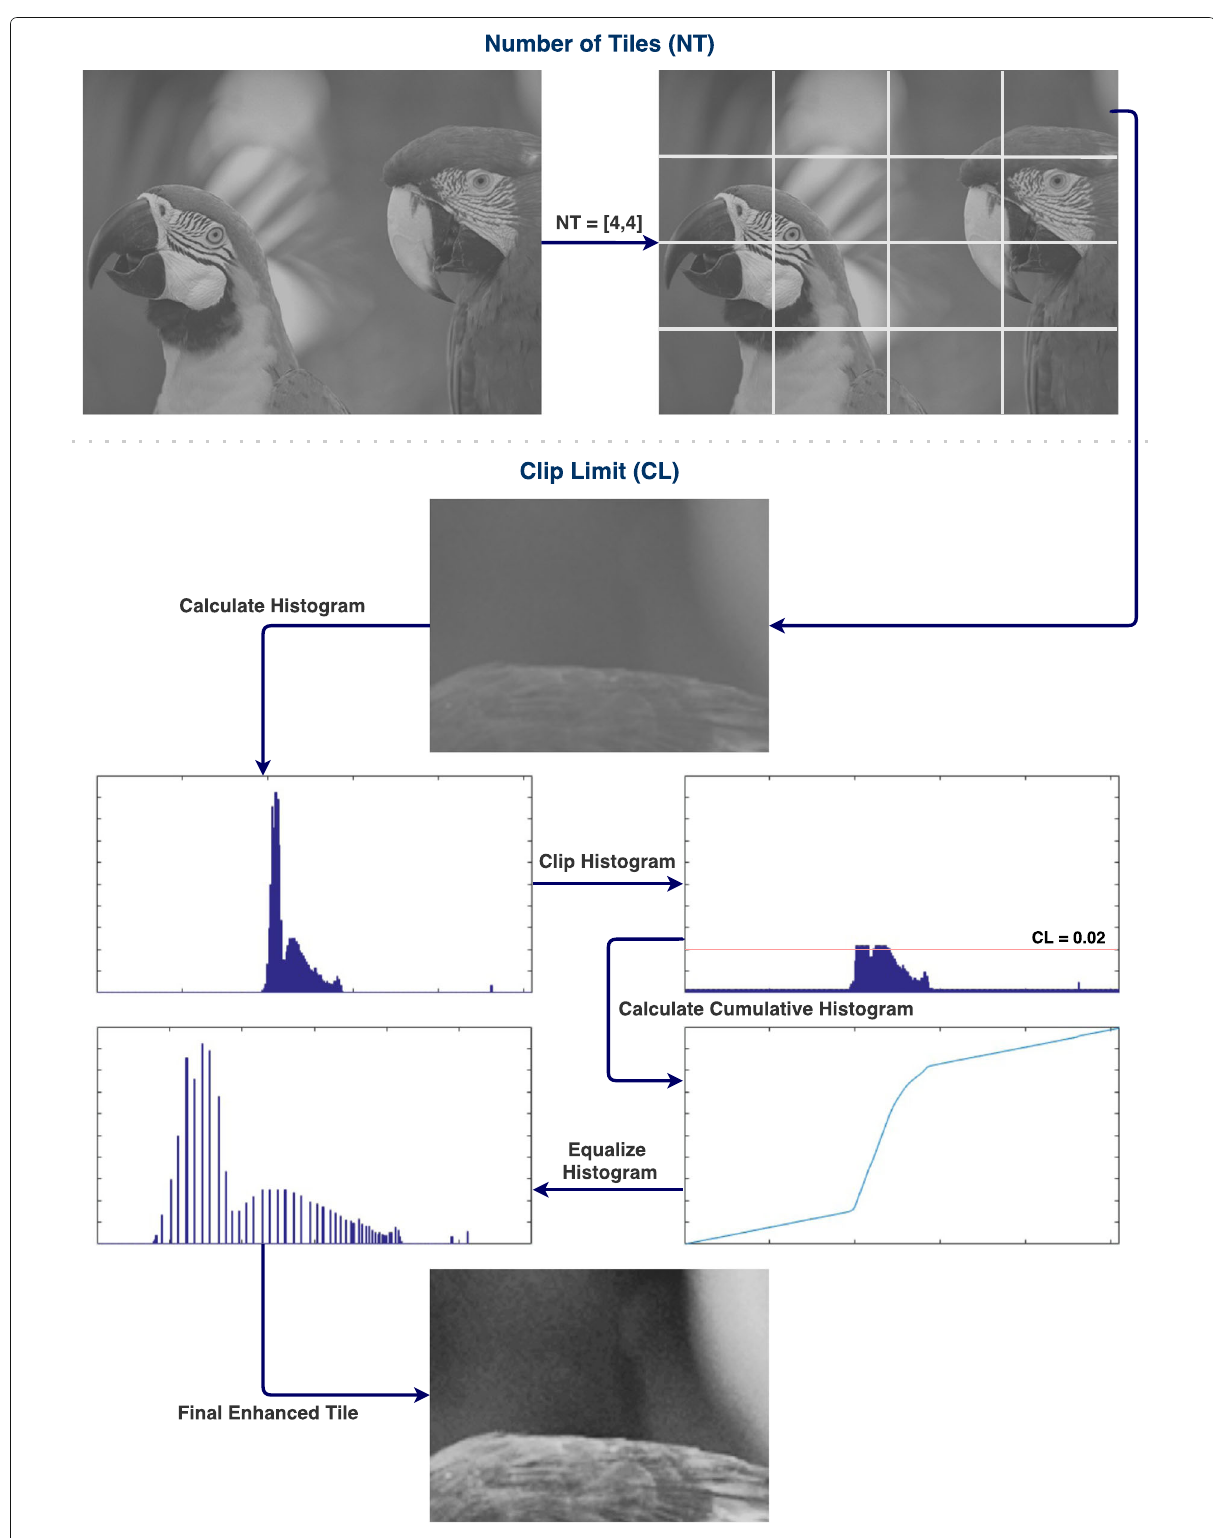
Fig. 1 Overview of CLAHE’s main parameters (CL and NT). Example with NT = [4,4] and CL =